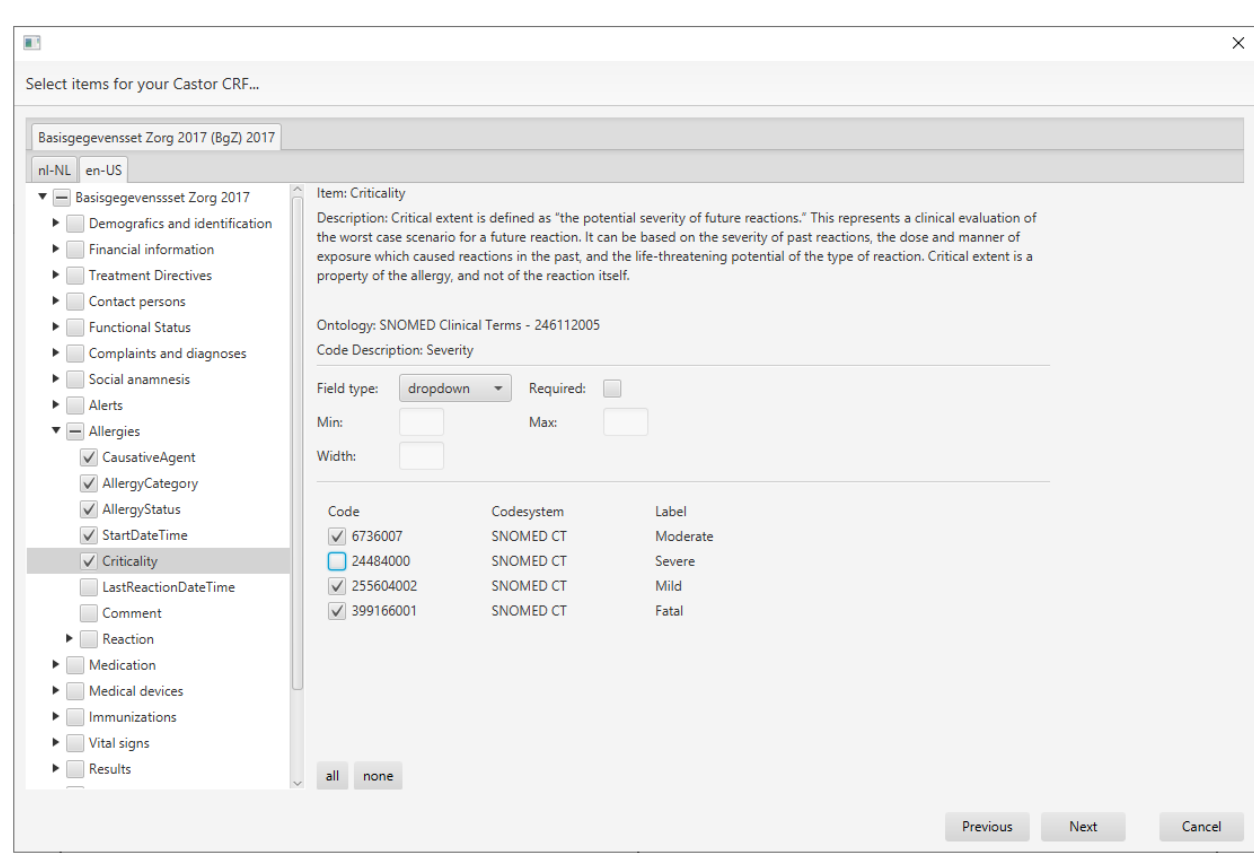
Figure 5. User selects items on the left-hand side in the tree and customises an item’s details in the electronic data capture system (EDC)-specific right-hand side.